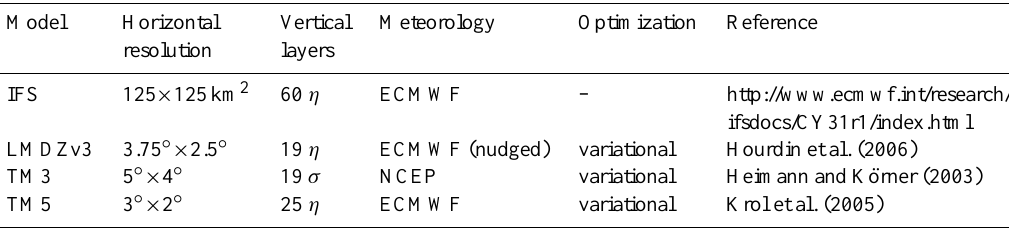
Table 2. Overview of participating models.